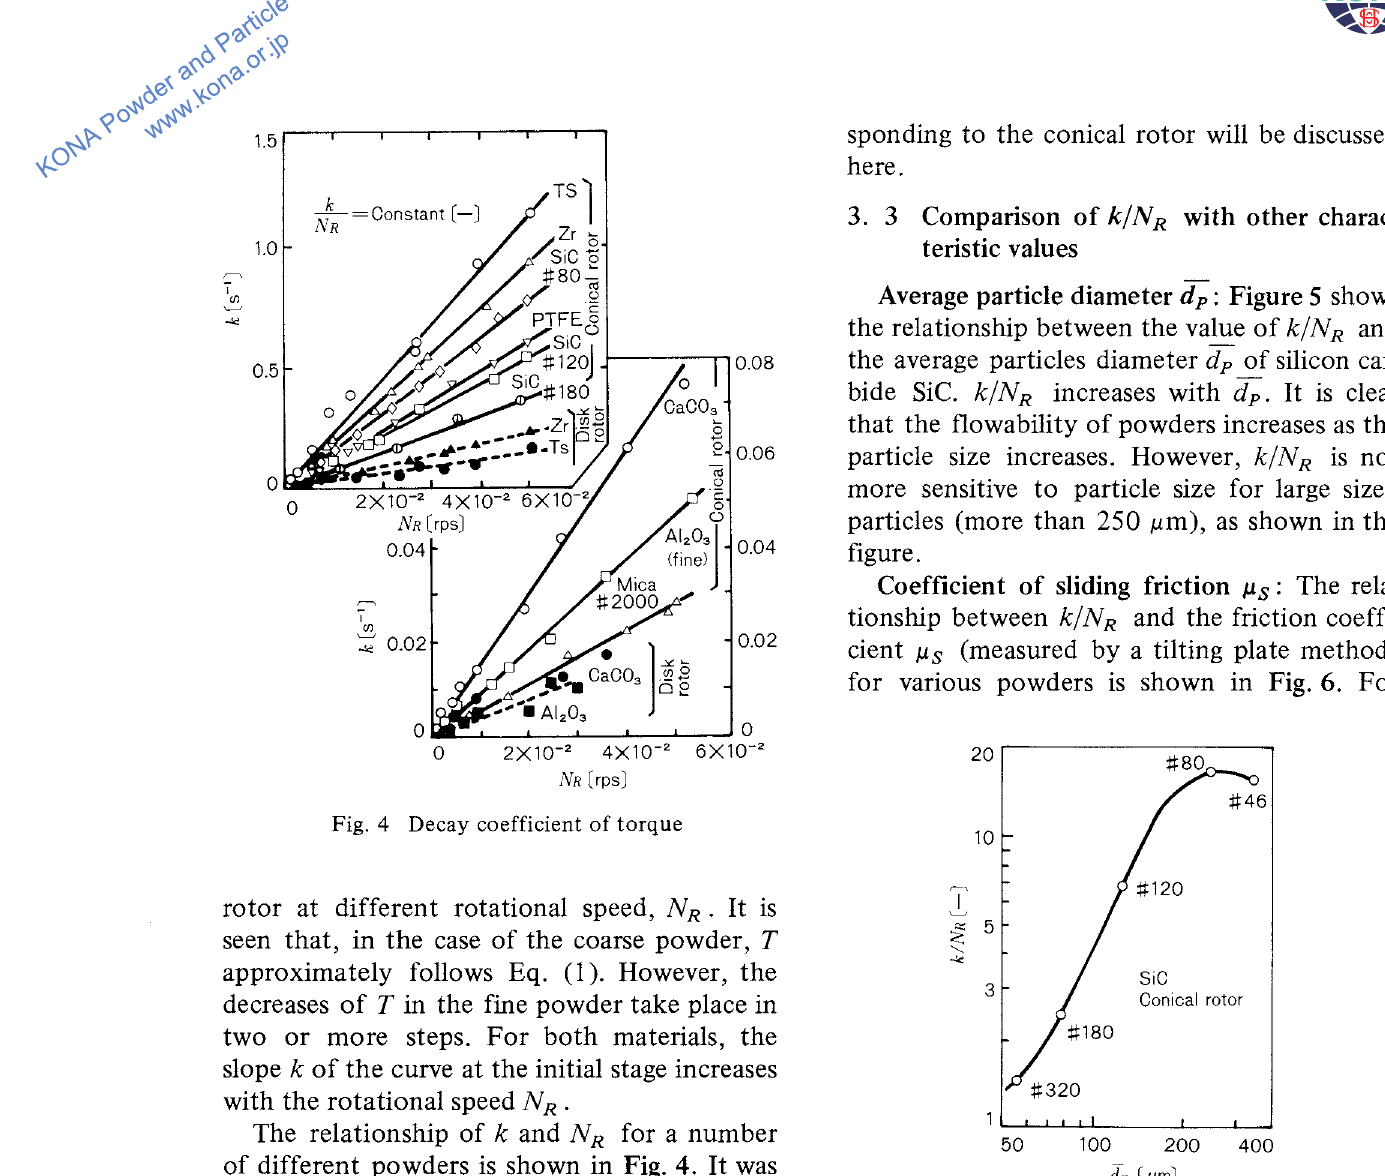
Fig. 5 Relationship between parameter k/N R and average diameter d p